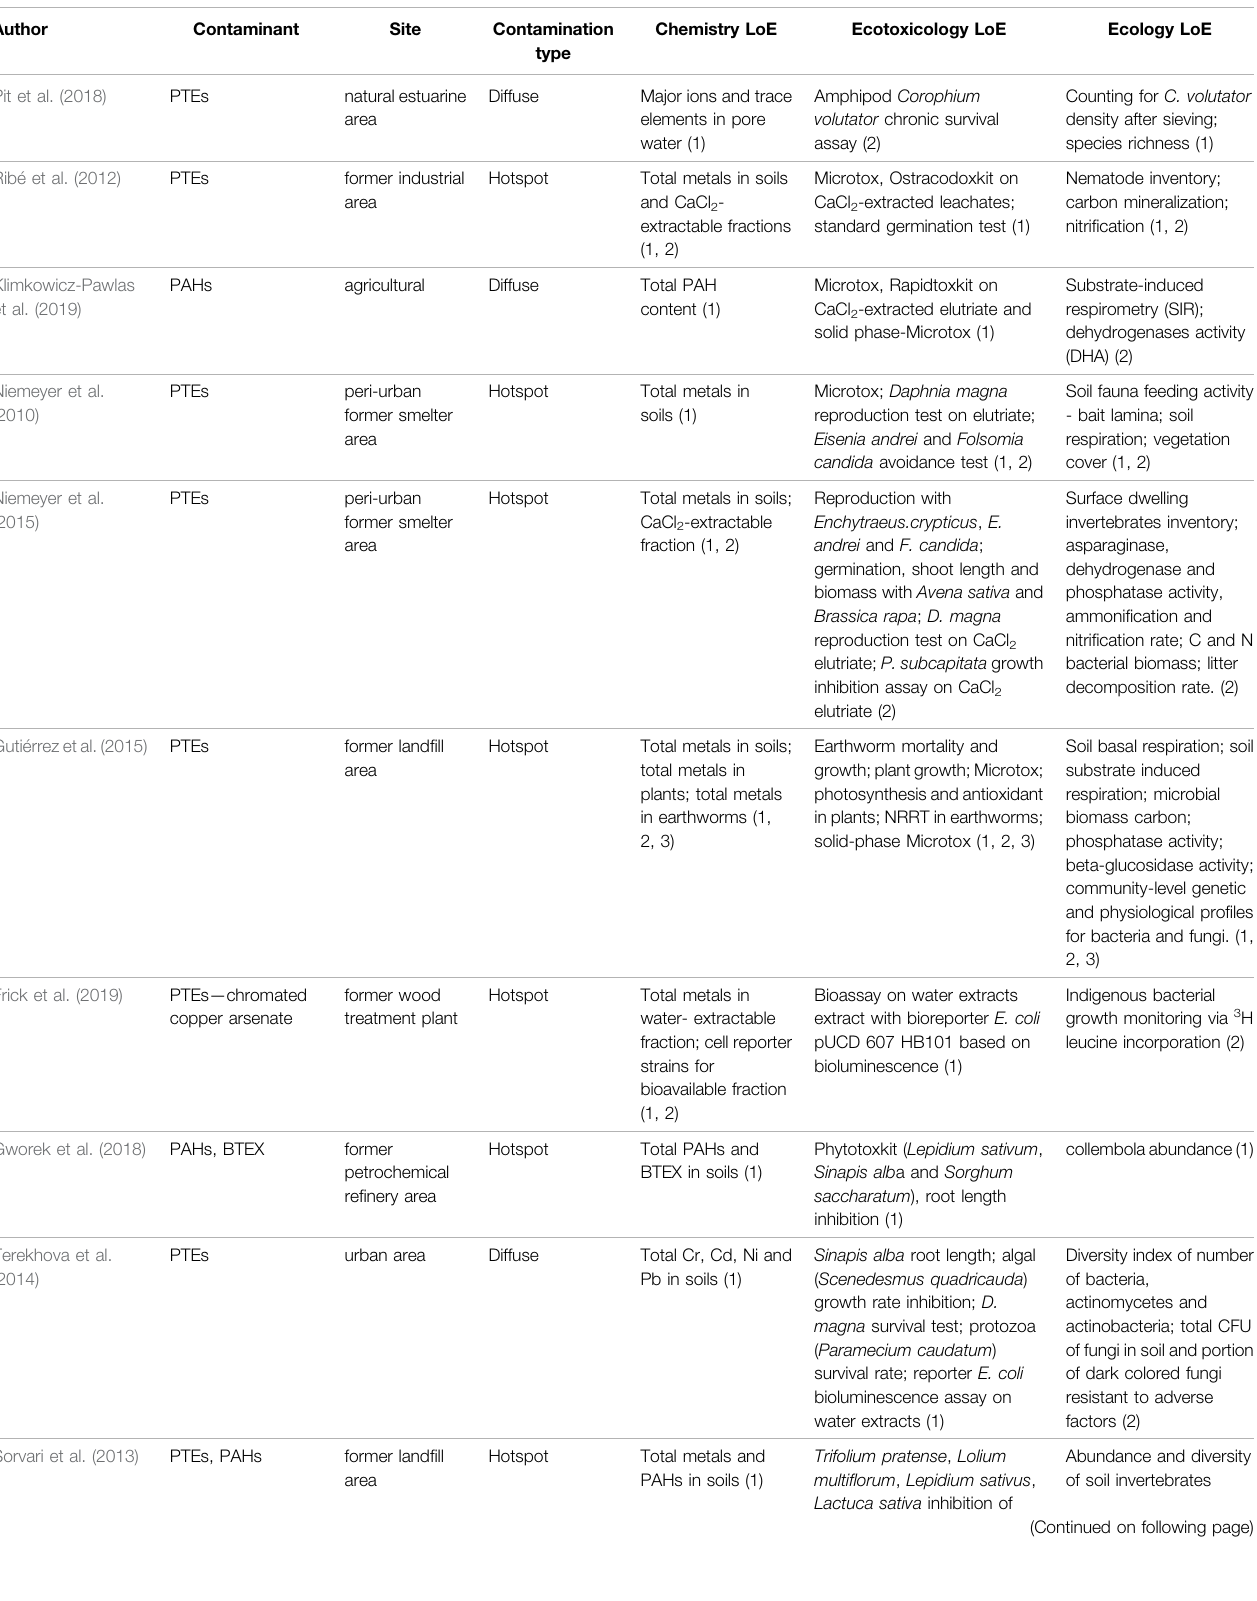
TABLE1| Summaryofthemaincharacteristicsextractedfromstudiesreportingatriadapproachincontaminatedsoil.ThereportedtriadlevelofeachLoEwaseitheralready stated in the literature or designated in the present study, when possible according to standard guidelines or to the authors ’ judgement. Numbers in brackets represent the assigned tier of each